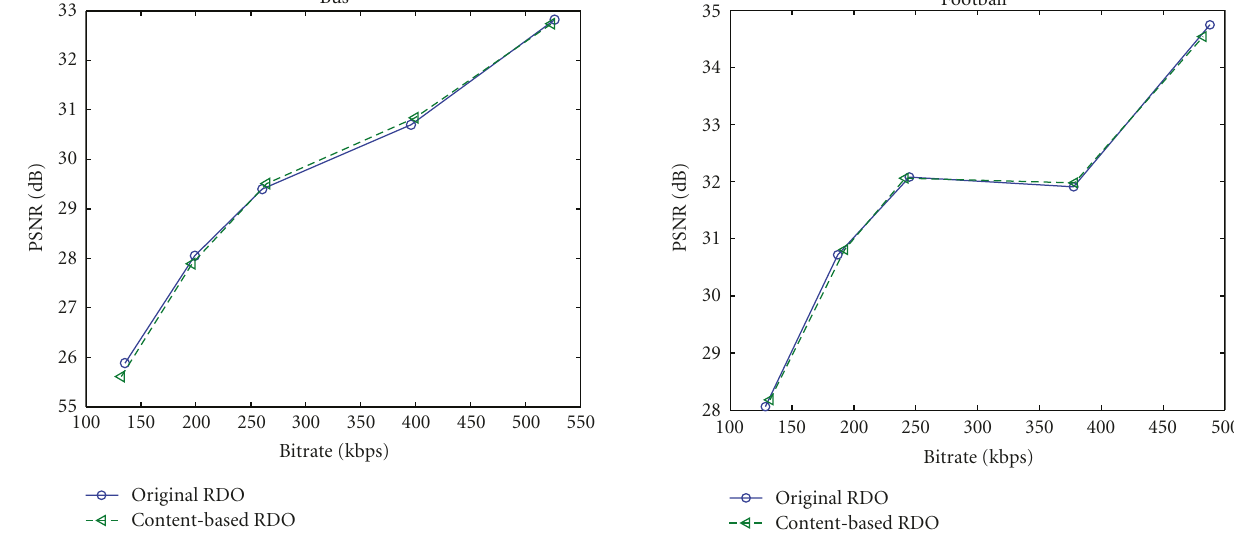
Figure 6: Comparison of PSNR results between the reference software and the proposed scheme for “Football.”